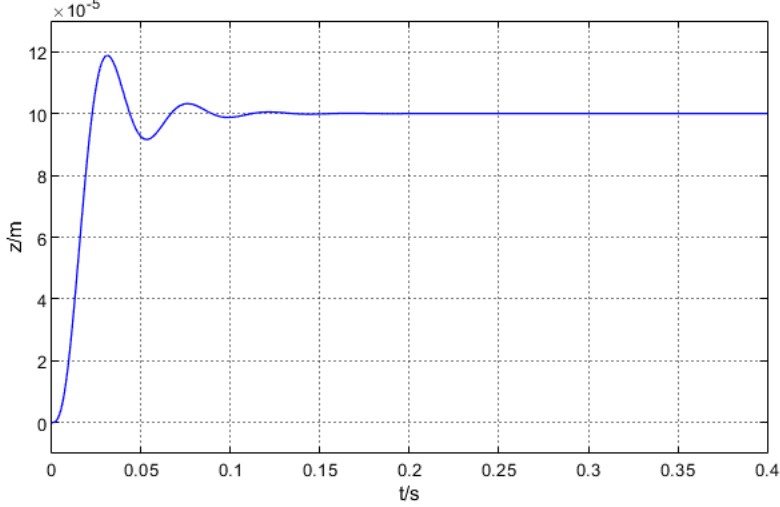
Figure 6. Time domain response of the system.